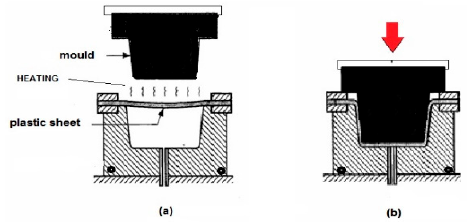
Figure 5. Thermoforming process [169].